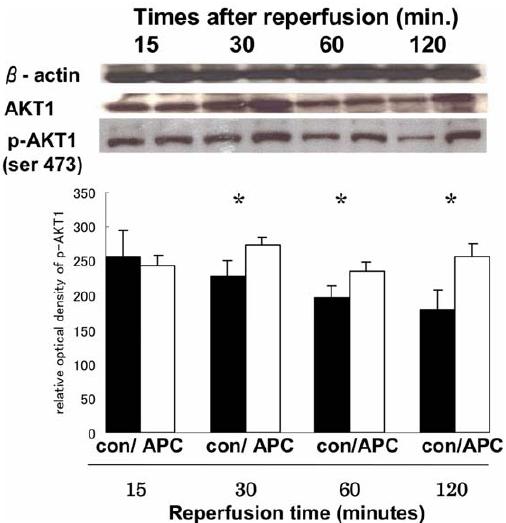
Figure 3. Representative Western blots for AKT1 and p-AKT1. The photograph shows Western blots of myocardium for b -actin, whole AKT1, and p-AKT1in the global ischemia/reperfusion injury model during the time course. AKT1 was strongly detectable 30 min after reperfusion in the activated protein C (APC) group (p=0.08, vs. control). The bar graph shows that p-AKT1 in the APC group was strongly and significantly expressed 30, 60, and 120 min after reperfusion, (* p , 0.05; APC group versus